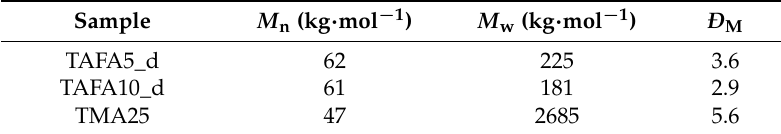
Table 5. Average molar masses and molar-mass dispersity of the terpolymeric